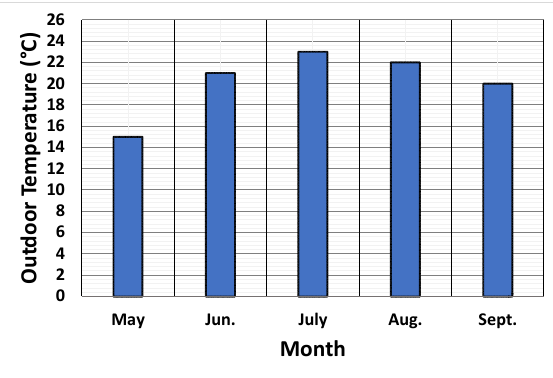
Figure 2. Averages of the outdoor temperatures (monthly) from May to September 2017. Table 2. Summary of the outdoor weather data for the location of the case study buildings. Mean Month/ Variables